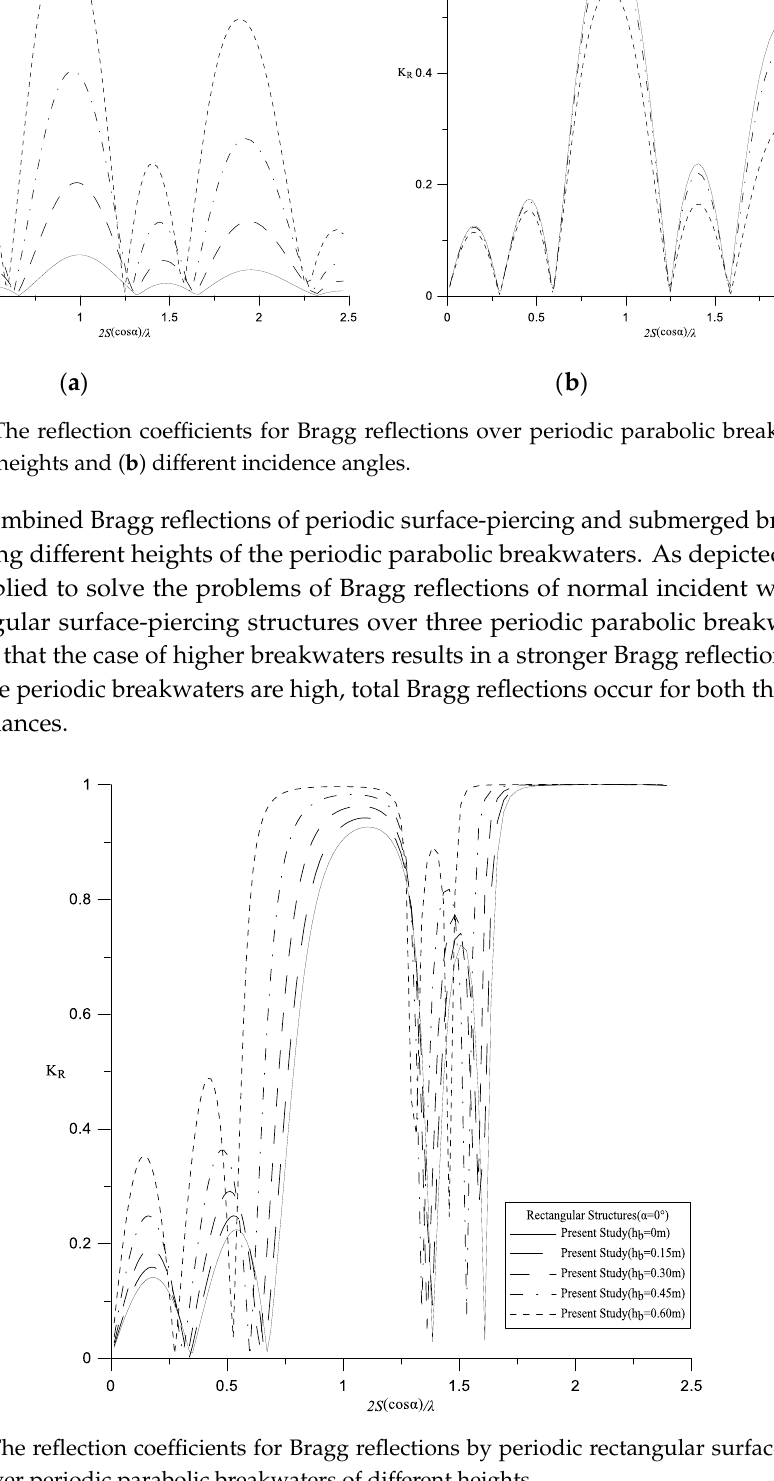
Figure 11. The reflection coefficients with different incidence angles for Bragg reflections by periodic ( a ) rectangular and ( b ) triangular surface-piercing structures over flat bottoms.